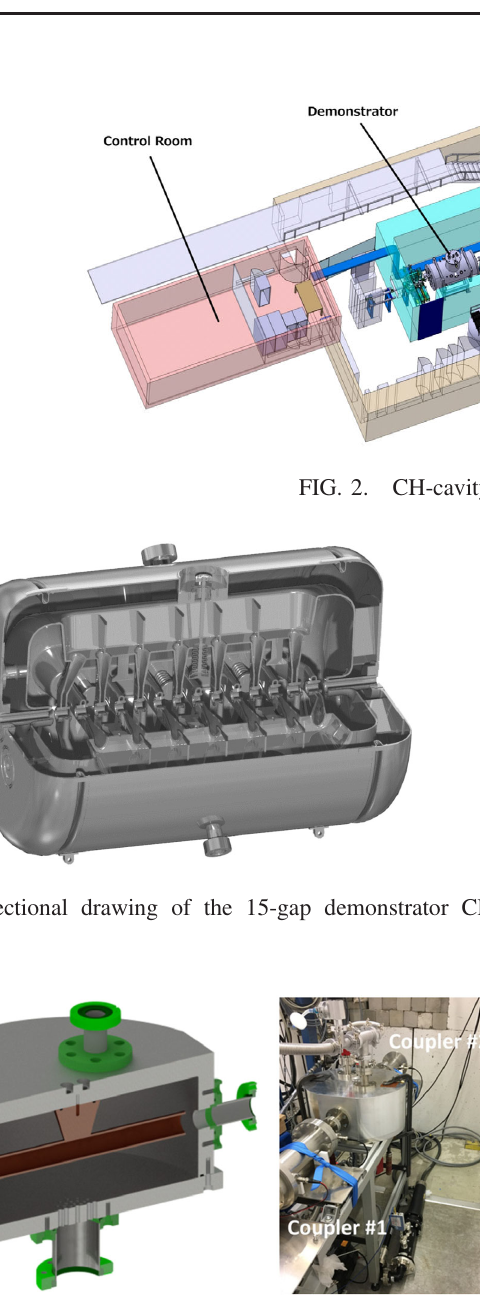
FIG. 4. Radio frequency testing cavity (left) for the rf power couplers at GSI; two couplers could be tested simultaneously (right) — the temperature at the outer coupler surface was mea- sured with sensors.